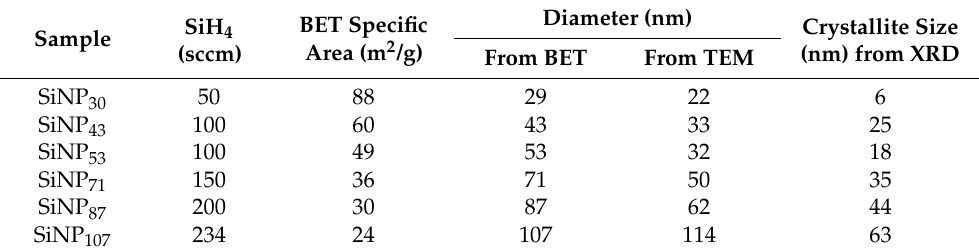
Table 1. Main experimental parameters and characterizations of the Si nanoparticles (SiNP)